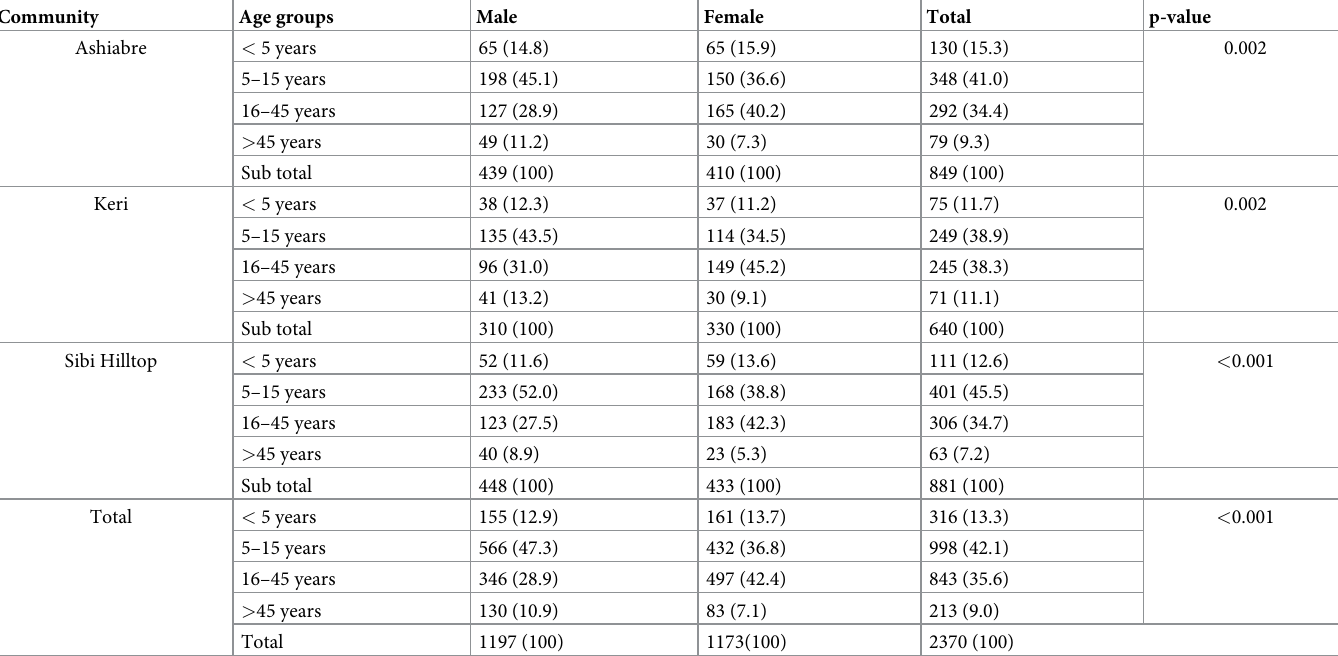
Table 10. Distribution of persons who used ITN the night before the survey by sex, age group and residence.